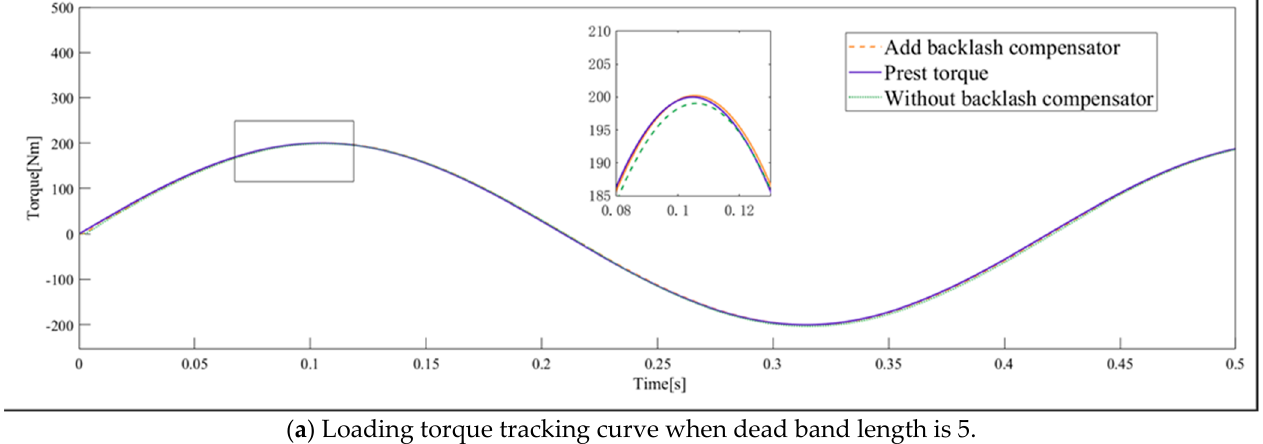
parameter difference in the aircraft steering gear electric load simulator with dual- motor loading structure.